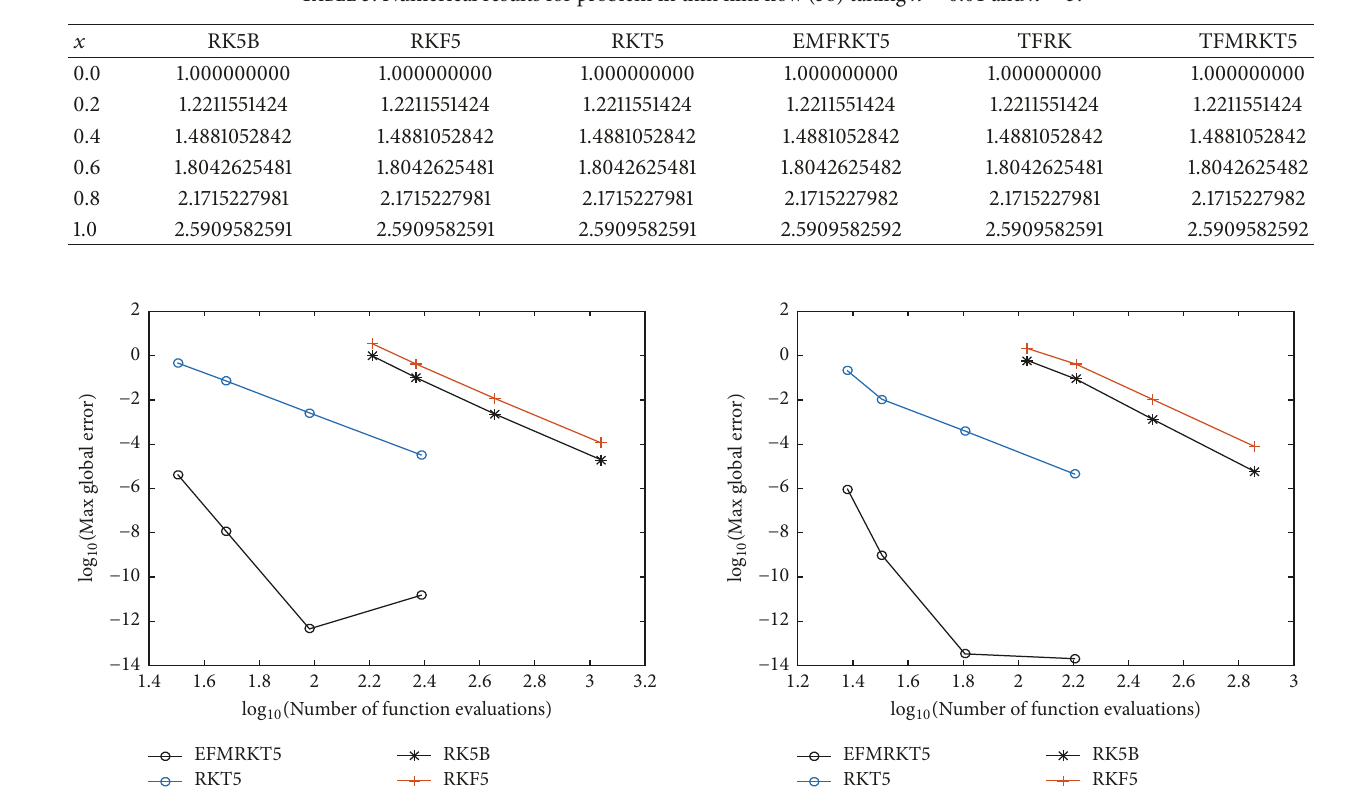
Table 5: Numerical results for problem in thin film flow (58) taking ℎ = 0.01 and 𝑘 = 3 .